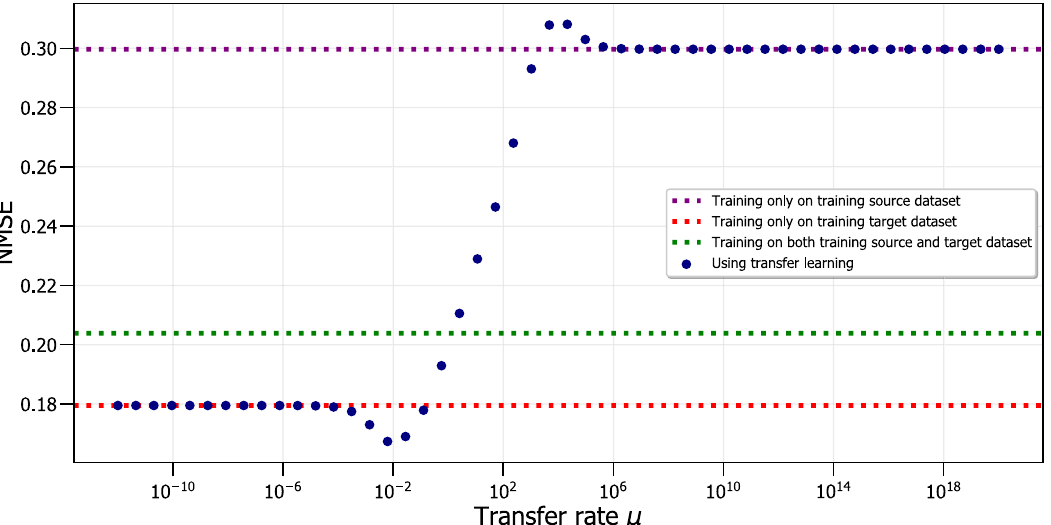
Figure 3: NMSE as a function of the transfer rate 𝜇 for predicting a Lorenz system with noise with different 𝜌 parameter, and comparison to conventional